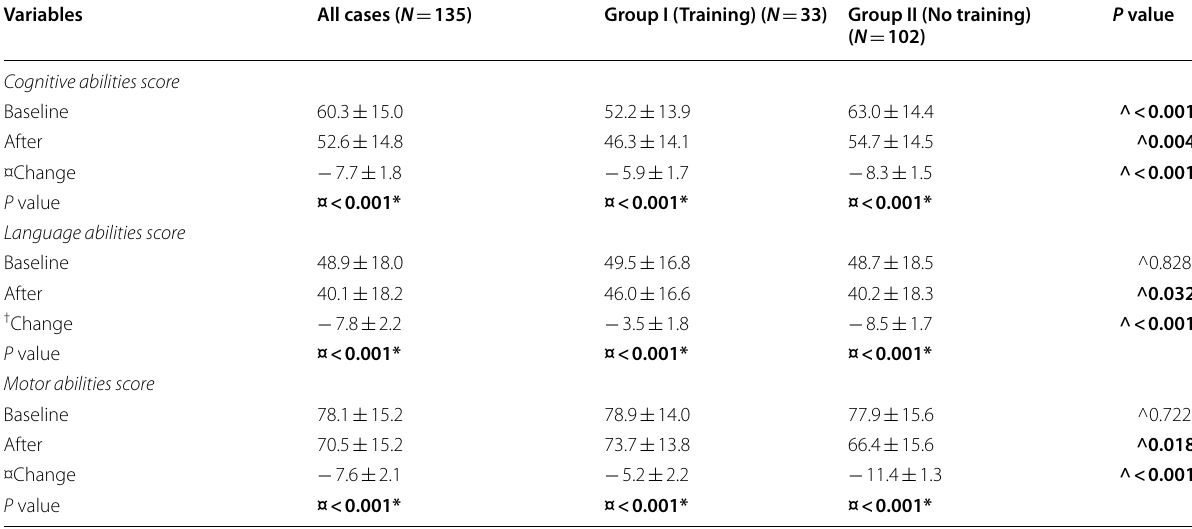
Bold indicates the level of significance was taken at P value < 0.050 † Change After-baseline (negative values indicate reduction). ^Independent t test. ¤Paired t test. #Chi square test. *Significant (< 0.050) =